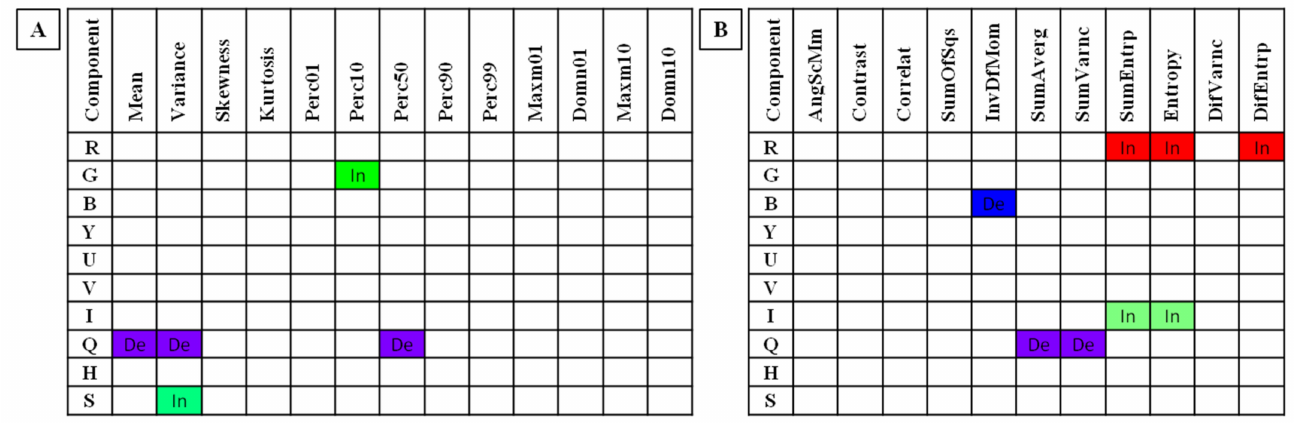
Figure 4. Features of ( A ) Histogram Statistics and ( B ) Gray Level Co-occurrence Matrix for each examined color component found to be significantly increasing (In) or decreasing (De) with the progression of pregnancy. R—Red component in the RGB color model; G—Green component in the RGB color model; B—Blue component in the RGB color model; Y—Brightness component in the YUV/YIQ/HSB color models; U—U-component in the YUV color model; V—V-component in the YUV color model; I—I-component in the YIQ color model; Q—Q-component in the YIQ color model; H—Hue component in the HSB color model; S—Saturation component in the HSB color model. Skewness—skewness coefficient; Perc01, Perc10, Perc50, Perc90, Perc99—percentiles; Domn01, Domn10—dominants; Maxm01, Maxm10—maximum of moments; AngScMom—angular second moment/energy; Correlat—correlation; SumOfSqs—sum of squares;